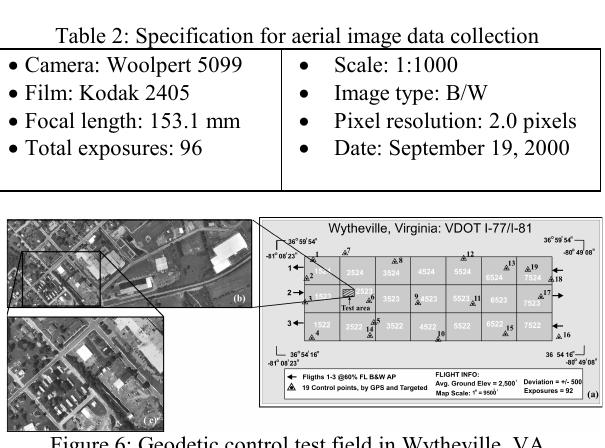
Step 1: Co-registration between orthoimagery and LiDAR point cloud data. Figure 7 is the result for co-registration between orthoimagery and LiDARdata point using XY geodetic coordinates of the 6 conjugate points.